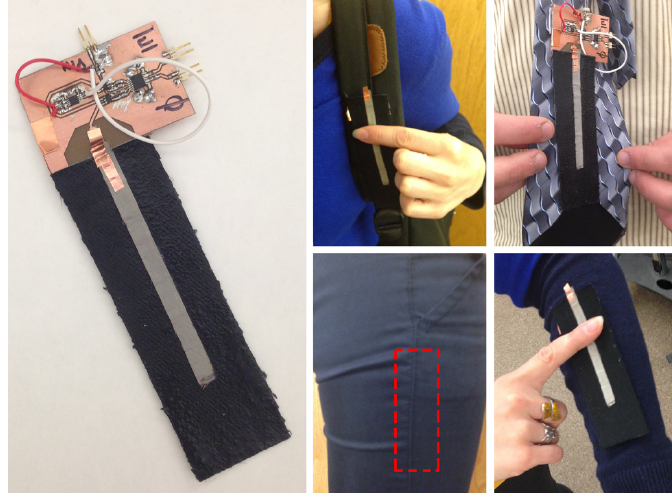
Figure 1. Prototype RF-based microstrip swatch and reflectometer circuit. Possible placements and applications are shown. From